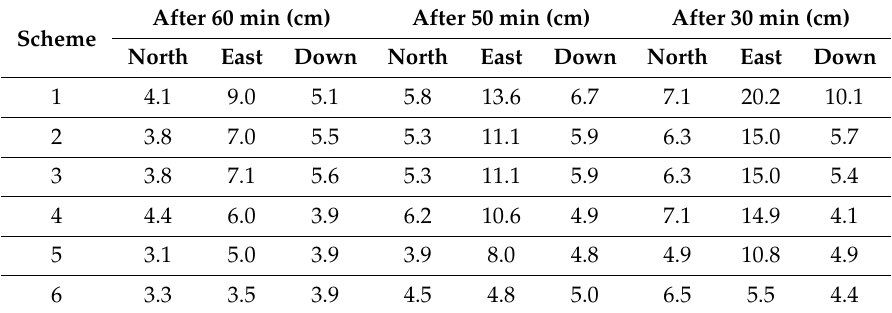
Table 1. RMS of the position difference from six different schemes with respect to the reference solution. After 60 min (cm) After 50 min (cm) After 30 min (cm) Scheme North East Down North East